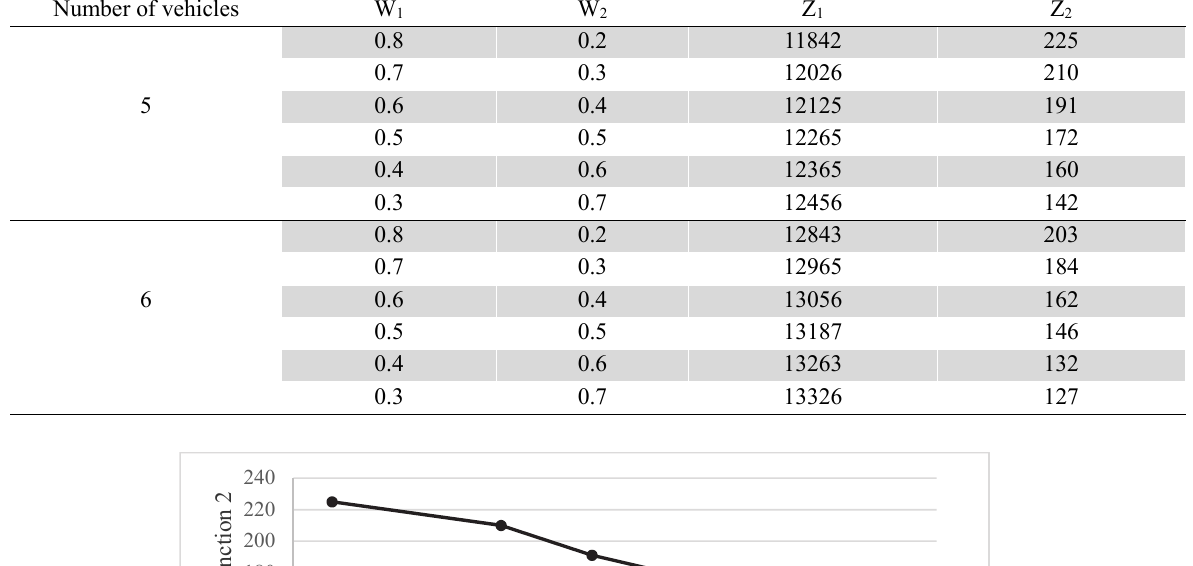
Fig. 10 . Pareto frontier of the problem by five vehicles.